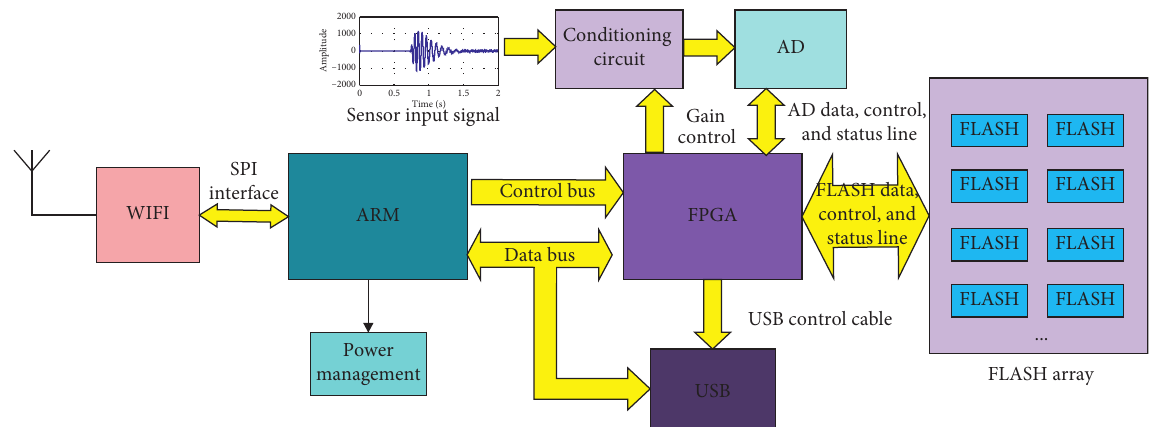
Figure 8: Design block diagram of the multichannel synchronous data acquisition